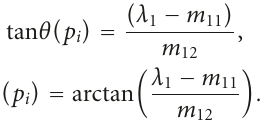
1D wavelet decomposition utilizing the “harr” basis